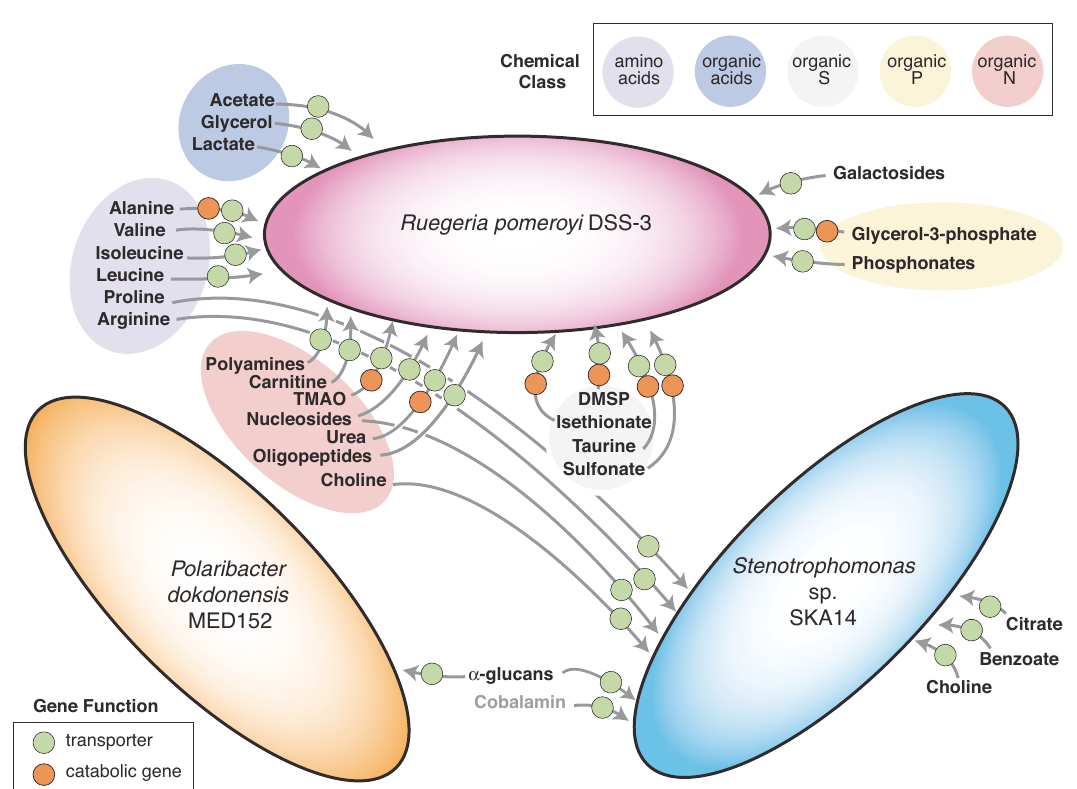
Fig. 1 Metabolites hypothesized to mediate autotroph-heterotroph carbon transfer for three model marine bacteria in co-culture with M. commoda . Circles specify genes which enable transport (green) or catabolism (orange). Shaded ovals identify chemical classes of metabolites. Cobalamin (vitamin B 12 ) was added to the growth medium (light gray